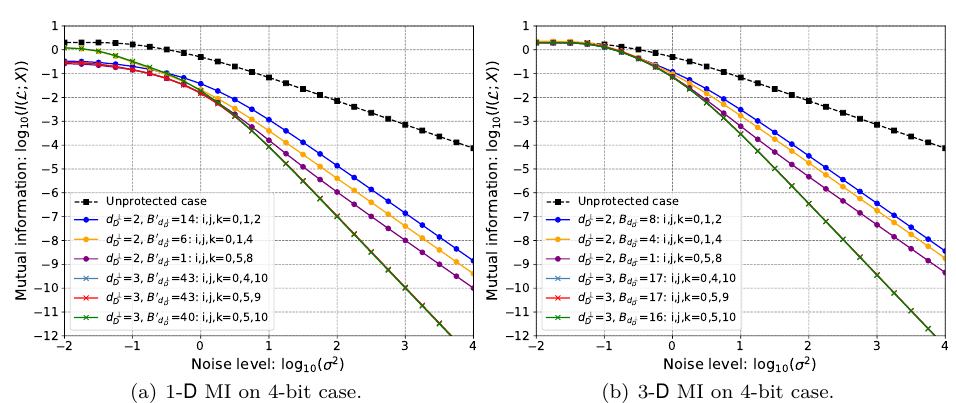
Figure 6: An information-theoretic evaluation of the leakages L and the sensitive variable . Six codes are chosen with different d ⊥ X ∈ F 2 4